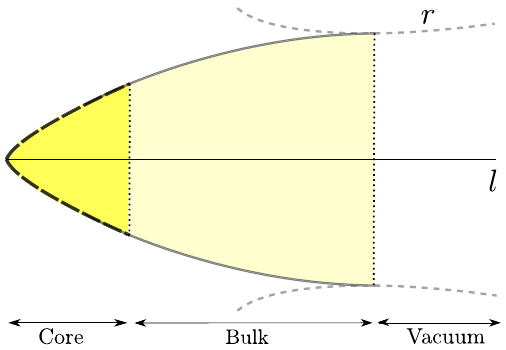
Figure 1. Pictorial representation of a semiclassical relativistic star. The areal radius r of spheres is shown √ 1 − C . The vacuum region (gray dashed lines) is the in terms of a proper coordinate l , defined as dr / dl = semiclassical Schwarzschild solution 32 describing an asymmetric wormhole. The bulk (gray continuous lines) is well described by the Polyakov approximation. This approximation breaks down at the core of the star (black dashed lines), but it can be minimally modified to adequately describe this